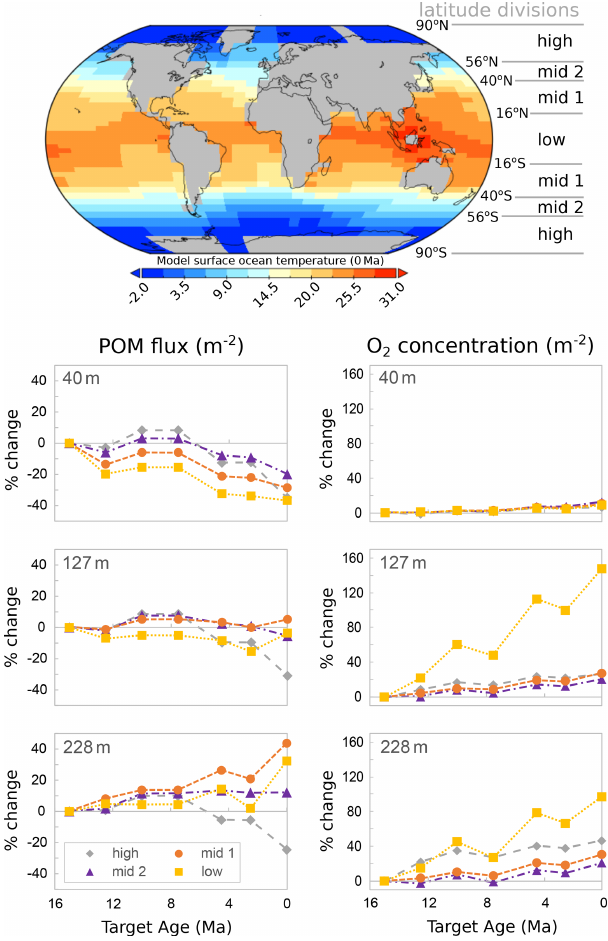
Figure 12. cGENIE model output for changes in particulate organic carbon (POC) flux and dissolved oxygen in near-surface ocean wa- ters from the middle Miocene to the present, with a temperature- dependent biological carbon pump. The inset map shows the mod- elled present surface ocean temperatures. Depths are the middle of cGENIE’s top three ocean